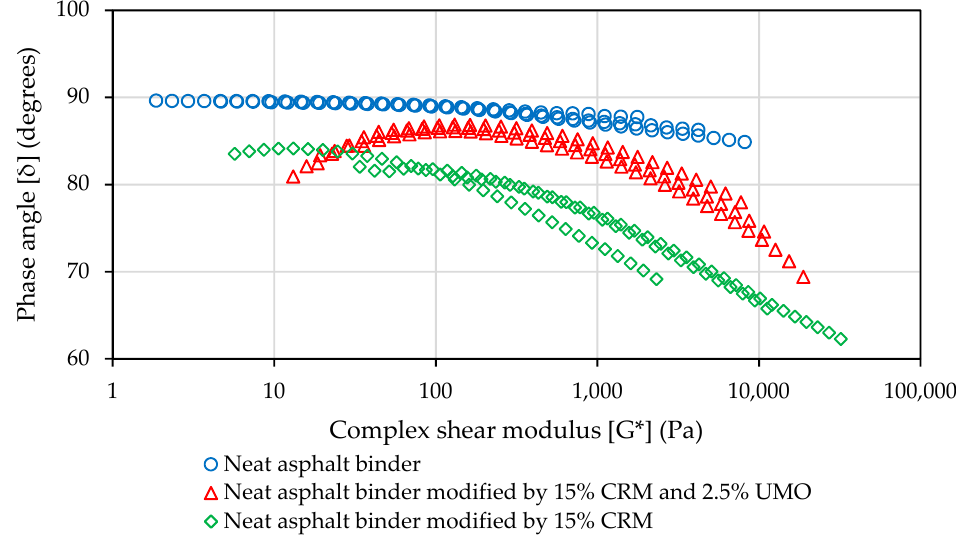
Figure 11. Black diagram for PG 52-28 neat and modified asphalt binders interacted at 170 ° C—50 Hz—75 min, measured at a reference temperature 60 °C.